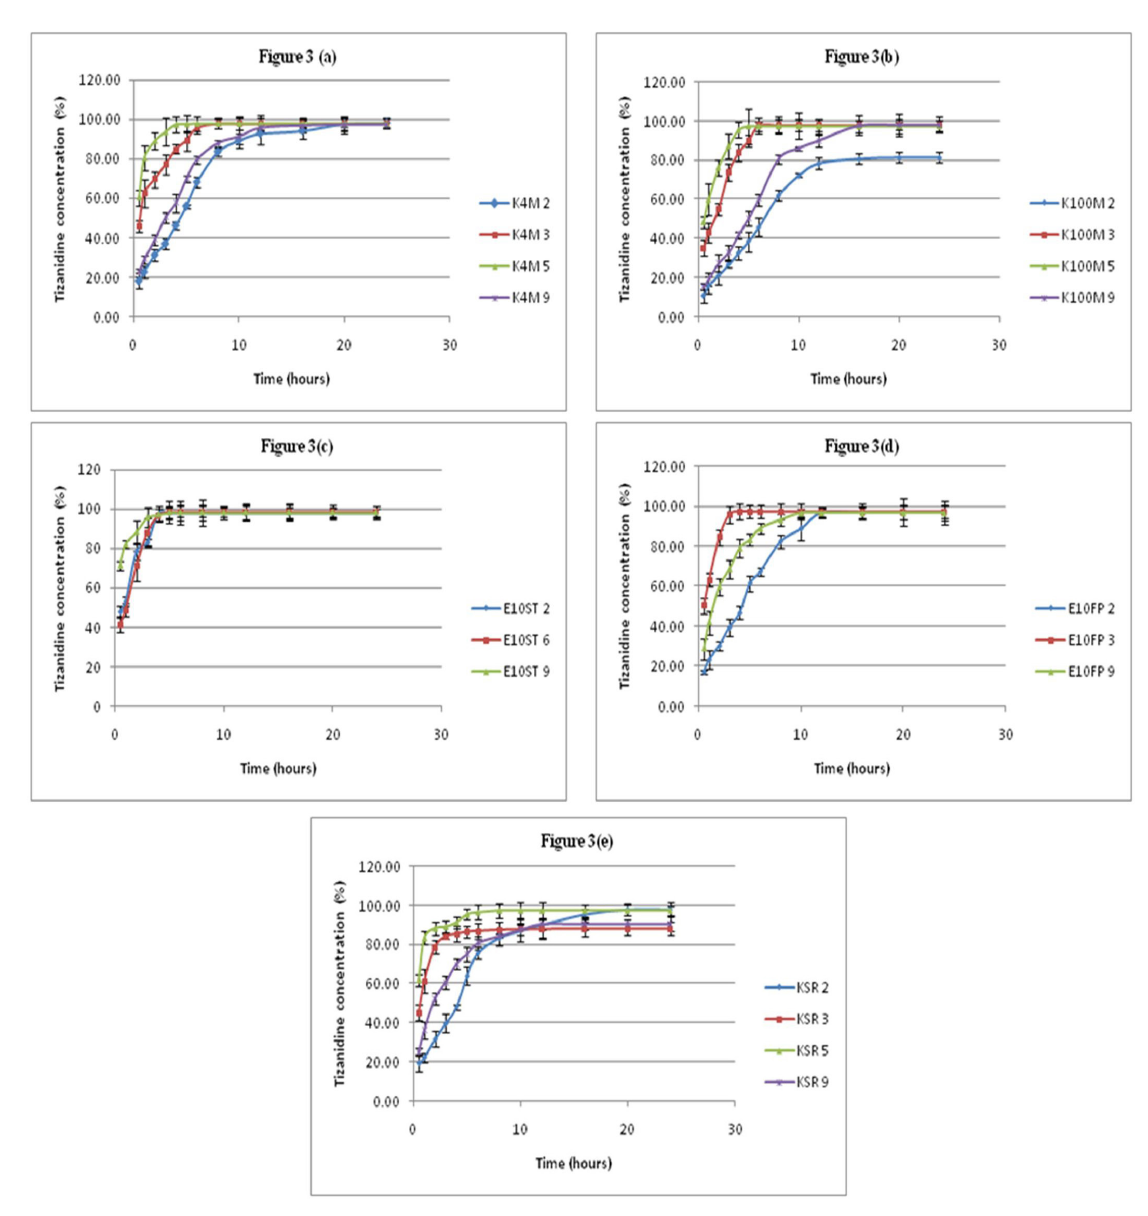
FIGURE 3 - Drug release profiles of tizanidine formulations in phosphate buffer pH 4.5 containing (a) HPMC K4M (b) HPMC K100M (c) Ethocel 10ST (d) Ethocel 10FP (e) Kollidon